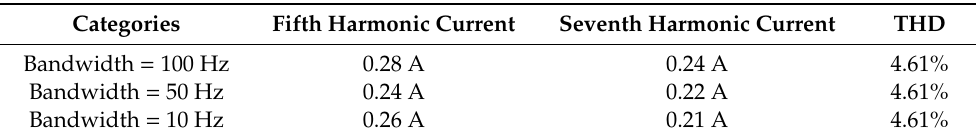
Figure 14. Simulation waveforms when applying the THE method: ( a ) output current, ( b ) FFT analysis result. Table 5. Performances of the THE method for different bandwidths.